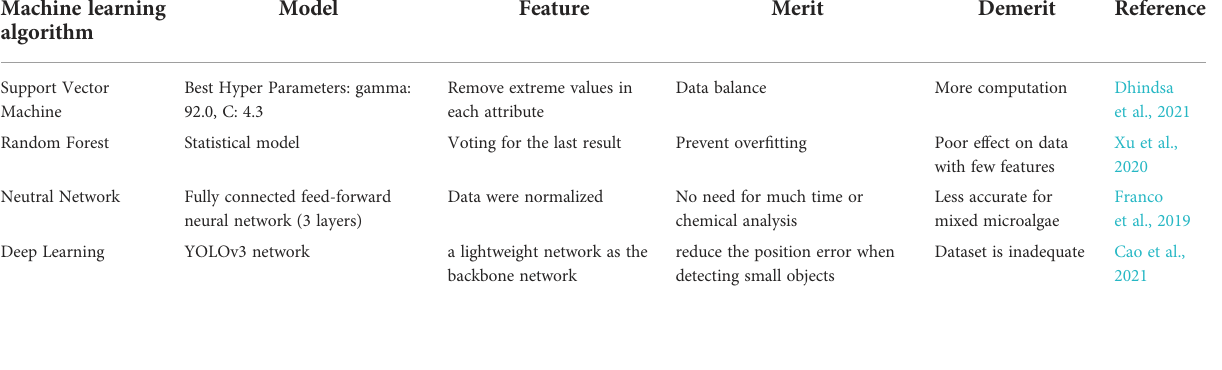
TABLE 1 Machine learning algorithms and models used in microalgae classi fi cation and detection. Machine learning